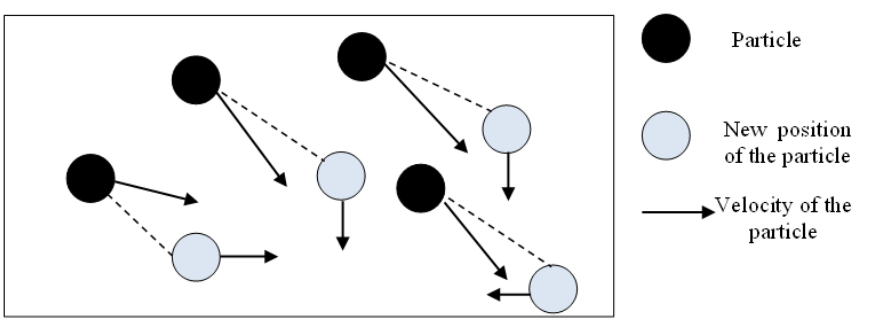
Figure 1. Particles with their related positions and